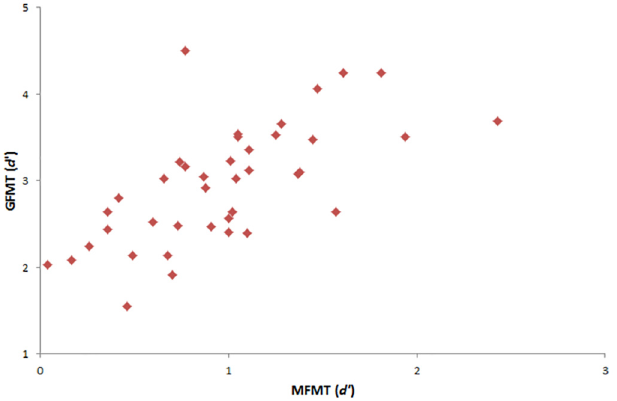
Fig 1. Correlation between GFMT and MFMT performance for all control participants.